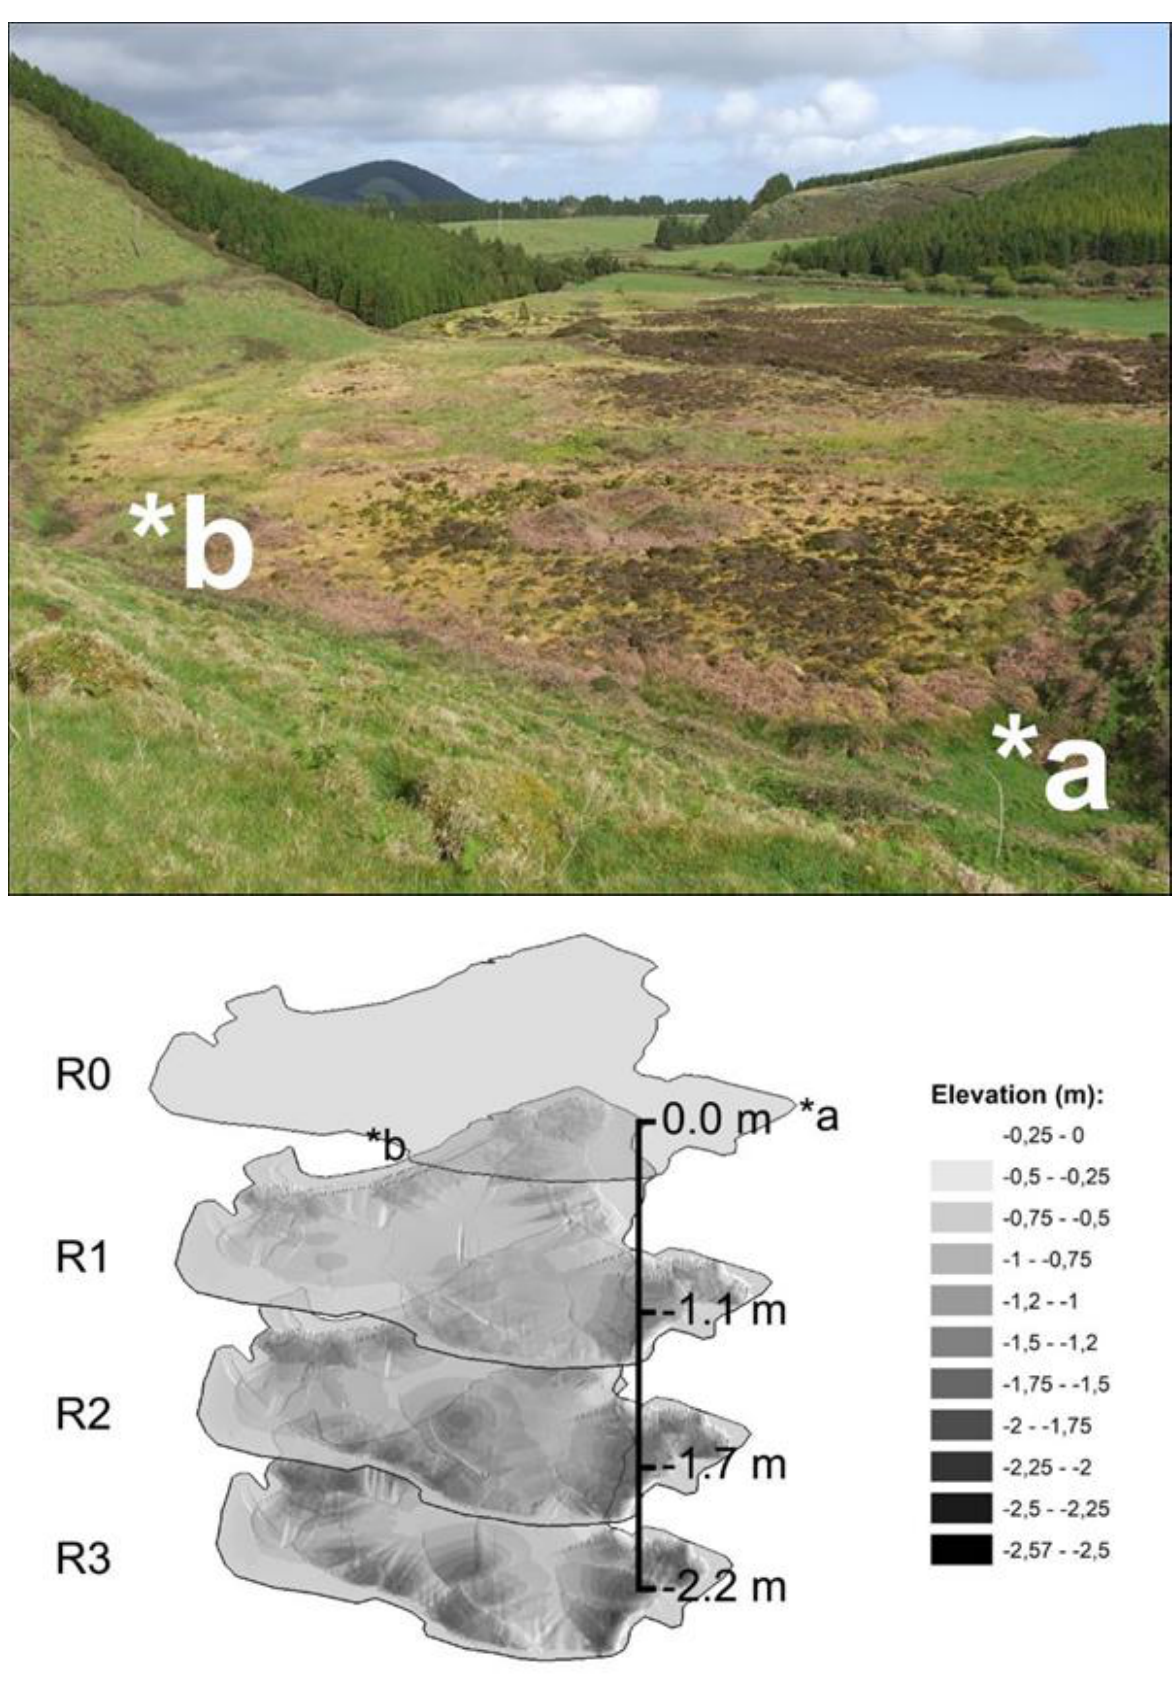
Figure 11. View across Peat Bog IV (above) and tridimensional GIS models of the reflectors/layers identified using the 500 MHz GPR antenna